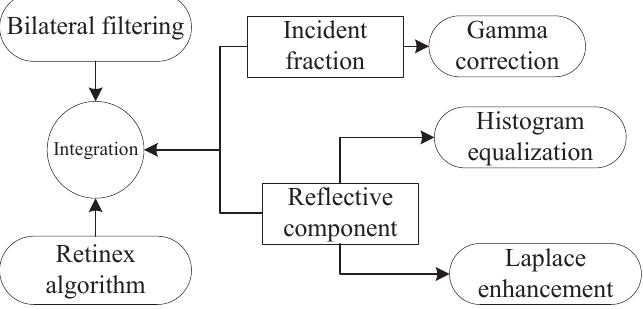
Figure 6. Structure diagram for processing the luminance component